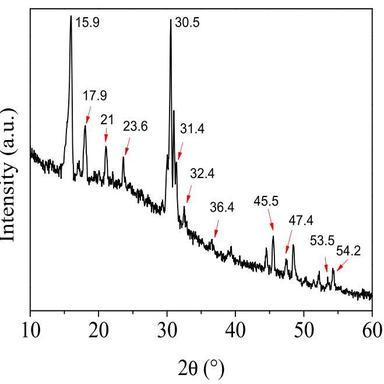
X-ray diffractograms of the EGnZVI.